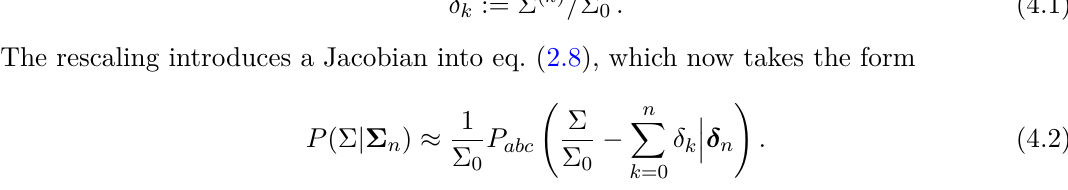
Figure 4 . The dependence of the probability distribution 1 /S 0 P abc (( S est metric series for n = 1 (dashed) and n = 3 (solid) on the parameters ( (cid:15), ω, η, ξ ) for 4 selected values, with the others held fixed at ( (cid:15), ω, η, ξ ) = (0 . 1 , 1 , 0 . 1 , 2)